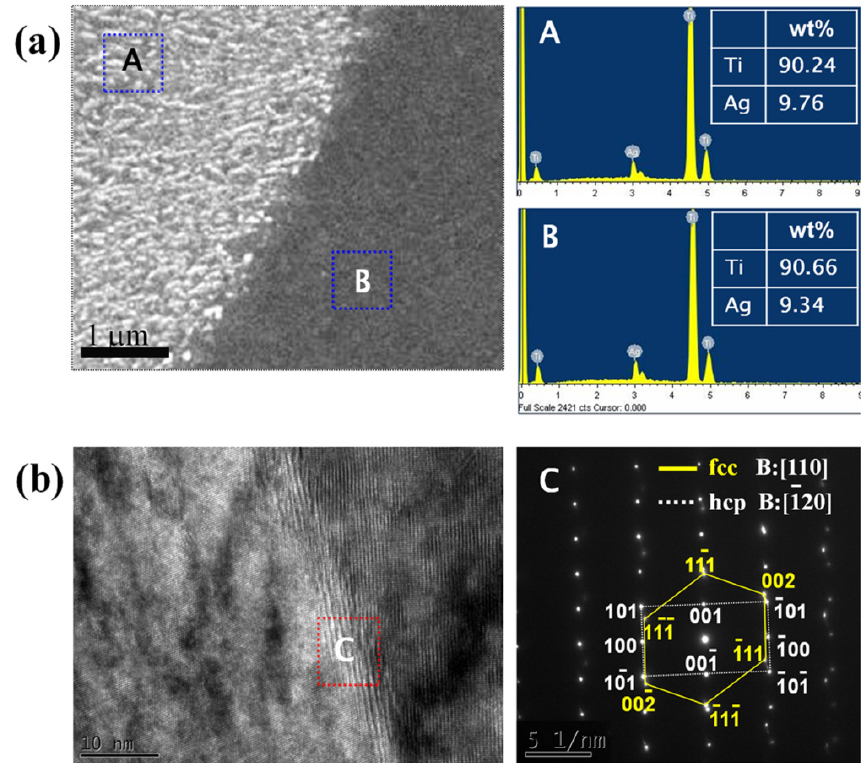
Figure 5. ( a ) SEM micrograph with quantitative EDX analysis of Ti–10Ag alloy; and ( b ) HR-TEM micrograph with the SAED pattern of the Ti–10Ag